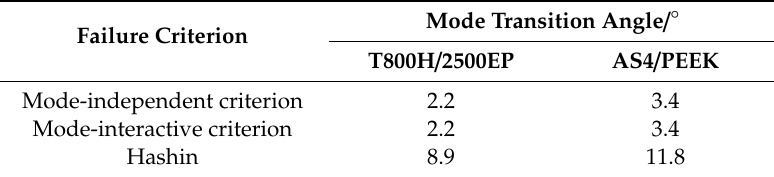
Figure 4. Comparison between the predicted off-axial tensile strengths and experimental results for ( a ) T800H/2500EP and ( b ) AS4/PEEK. Table 2. Mode transition angles induced by the o ff -axial